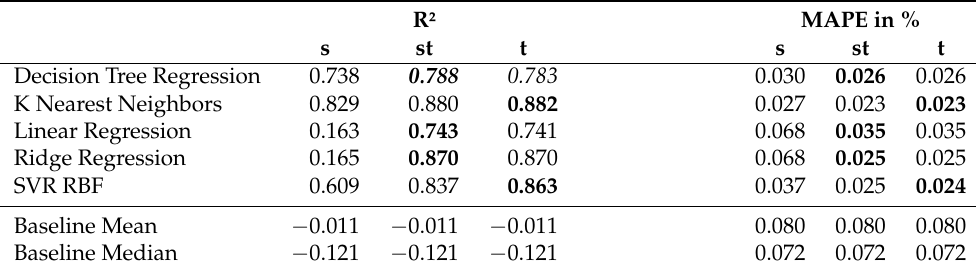
Table 9. Stacking Box Data Set II: results for Target Distance B. The differences in comparisons of st or t vs. s were tested for significance, using the Wilcoxon signed-rank test ( α = 0.05): where the test did not confirm significant differences, the respective st or t values are printed in italic. The highest R 2 and the lowest MAPE are shown in bold for each